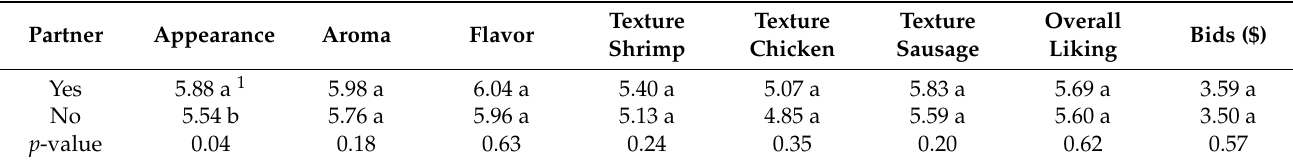
Table 6. Consumer liking responses and bid values for jambalaya meals as evaluated by participants who had or did not have a partner ( n = 50).